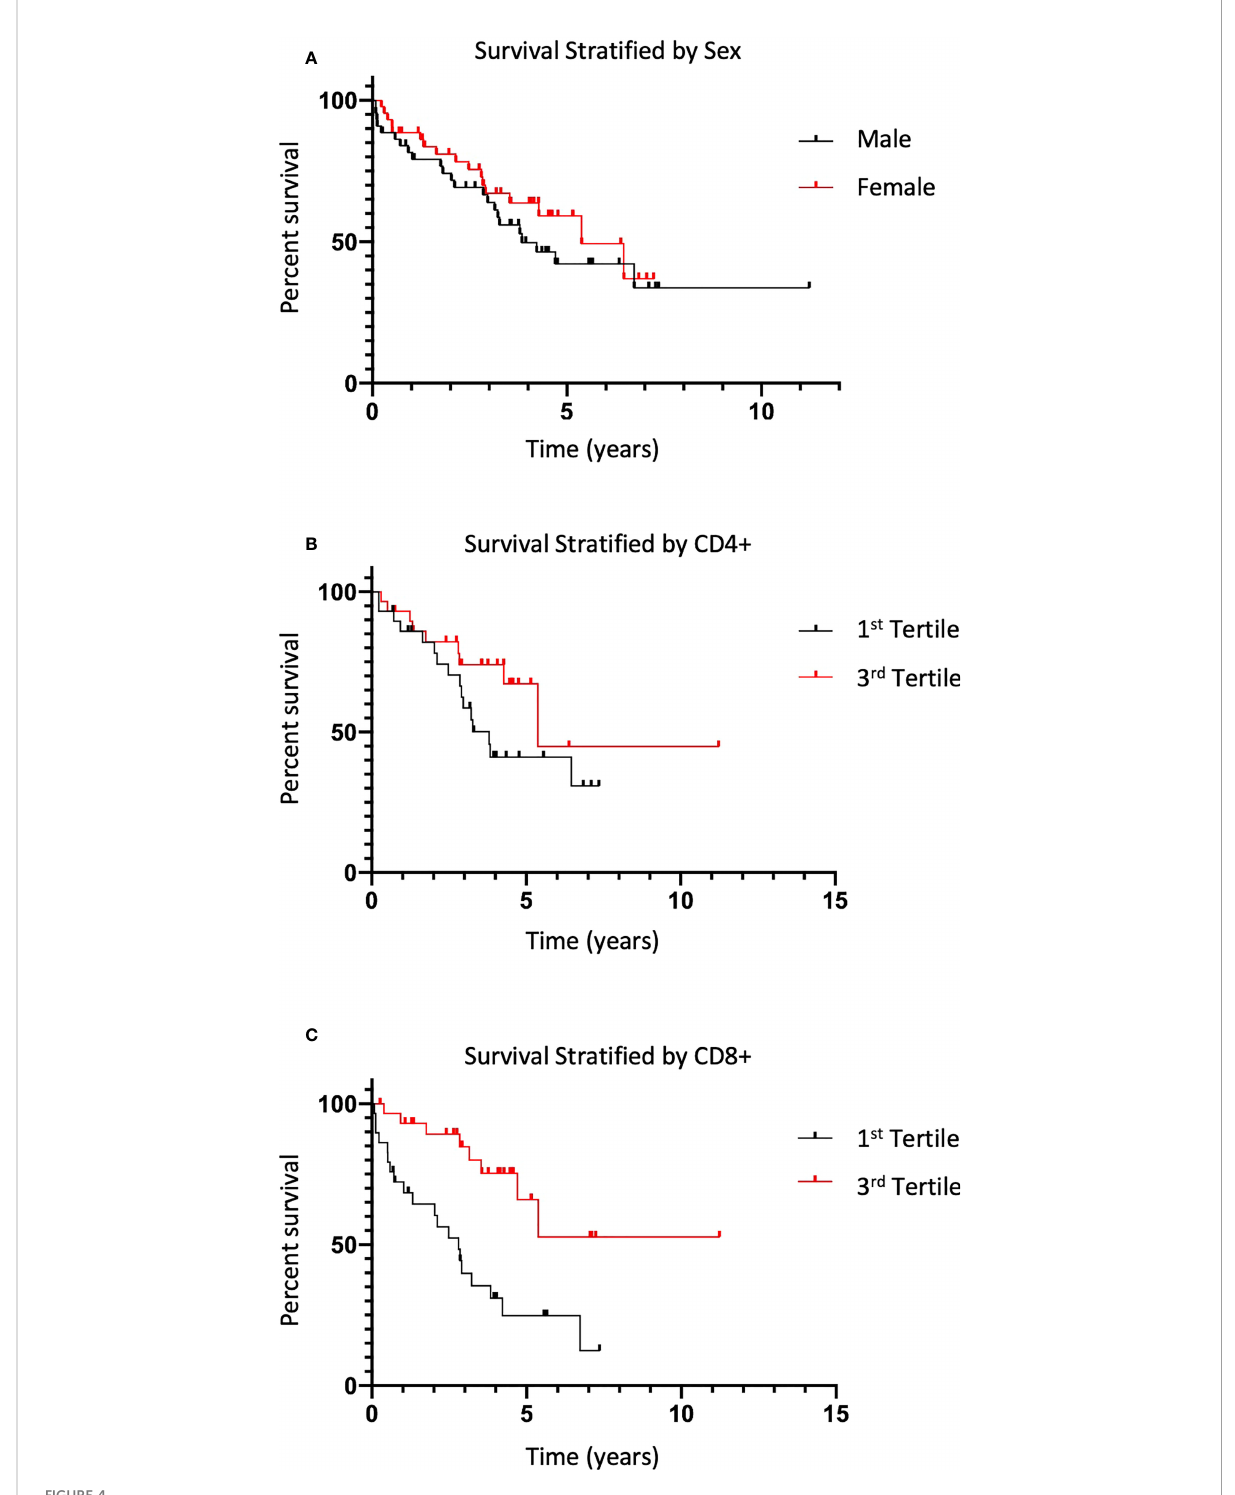
FIGURE 4 Survival is increased in patients with increased CD8+ in fi ltration. (A) Overall mean survival of CRC patients from the TMA dataset strati fi ed by sex are shown (38 vs 45 months, p=0.361). (B) Average difference in survival as de fi ned in (A) in patients within the 1 st tertile of CD4+ in fi ltration in tumor tissue compared to patients in 3 rd tertile (p=0.142). (C) Difference in survival as de fi ned in (A) in patients with 1 st tertile CD8+ in fi ltration in tumor tissue compared to patients in 3 rd tertile (43.9 vs 25.3 months,